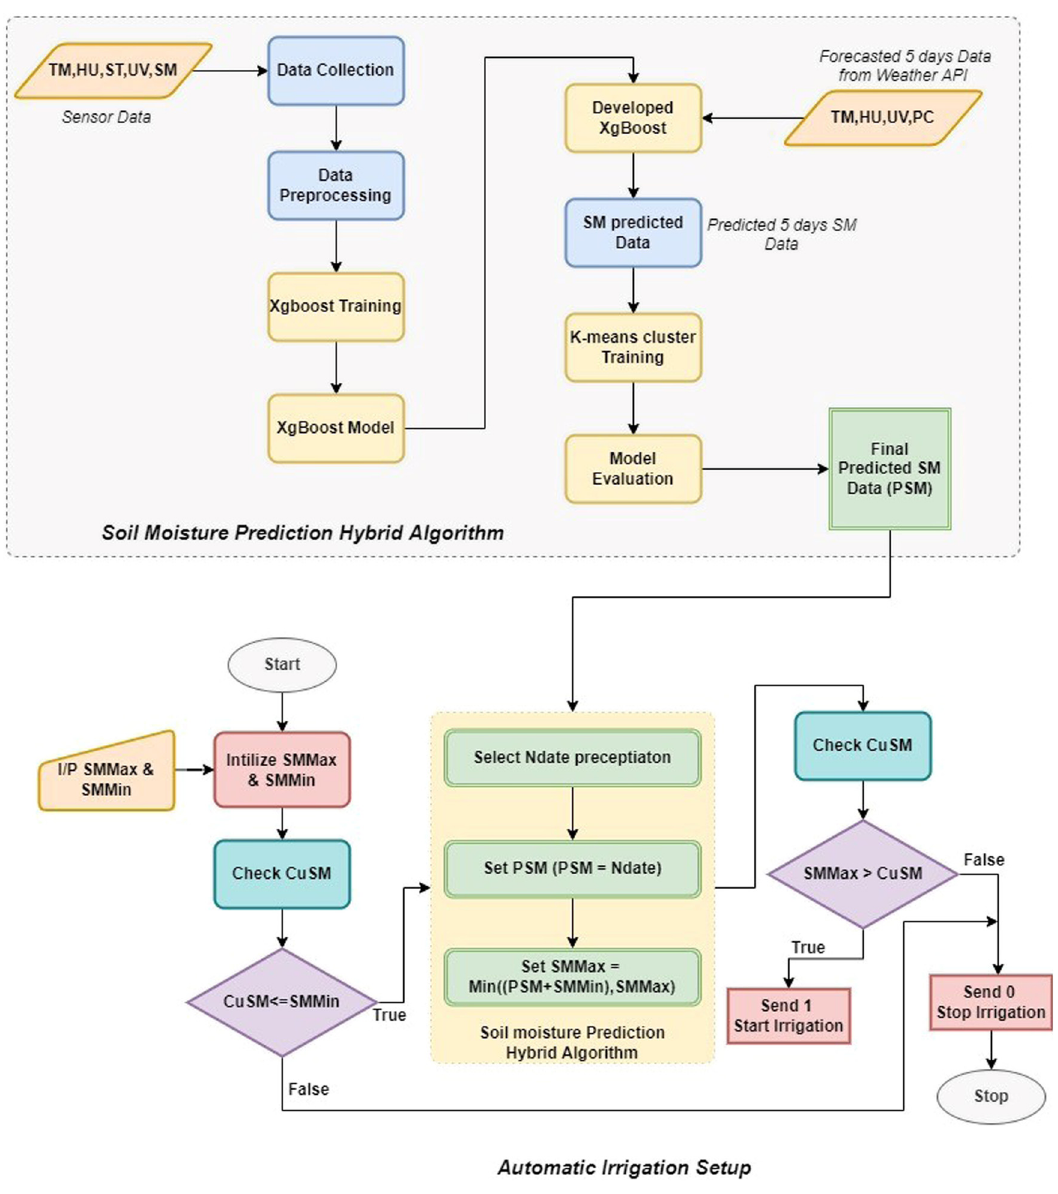
Figure 6: Flow chart of the proposed edge